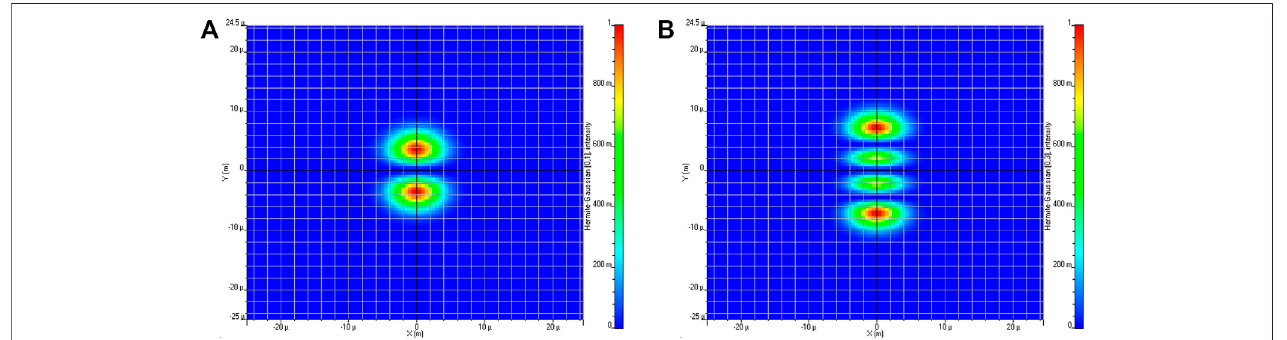
FIGURE 3 | Mode intensity pro fi le of (A) HG01 and (B) HG03.